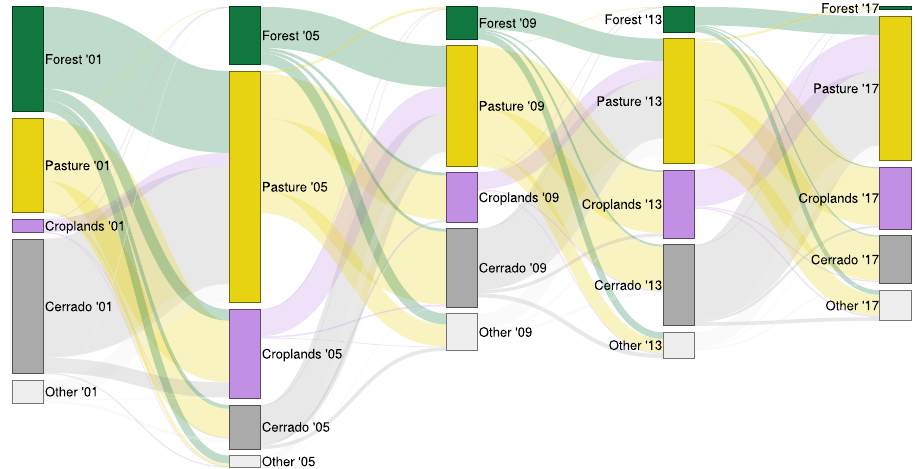
Figure 3. Direct land use change over selected years from 2001 to 2017. The height of flows represents the amount of yearly incoming/outgoing land use cover, the height of individual bars the maximum thereof. An interactive version of this figure with exact measurements of flows as tool-tip is provided as supplementary material. Also see Fig. 2 for a visualisation of land use cover in 2001 and